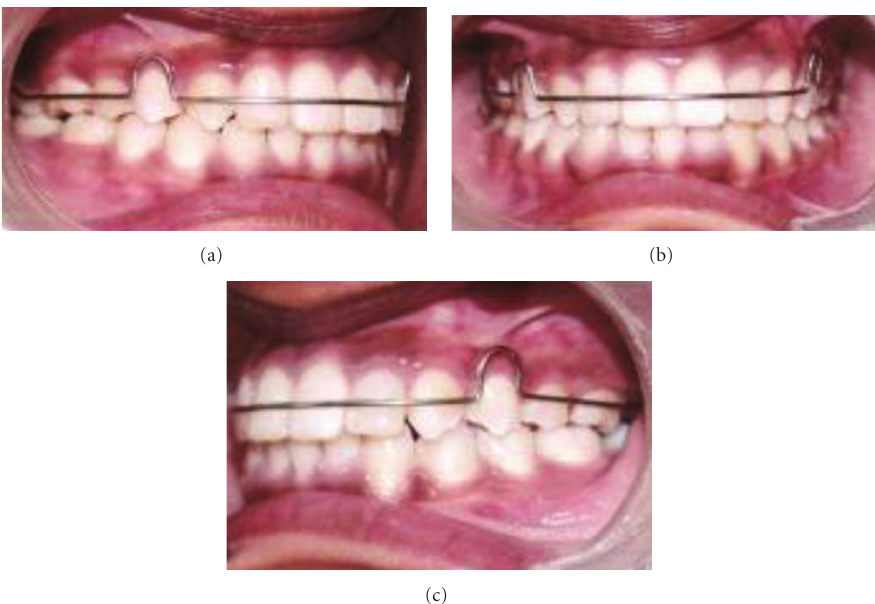
Figure 6: Postretention with Hawley’s retainer and lower fixed retainer at the end of leveling and